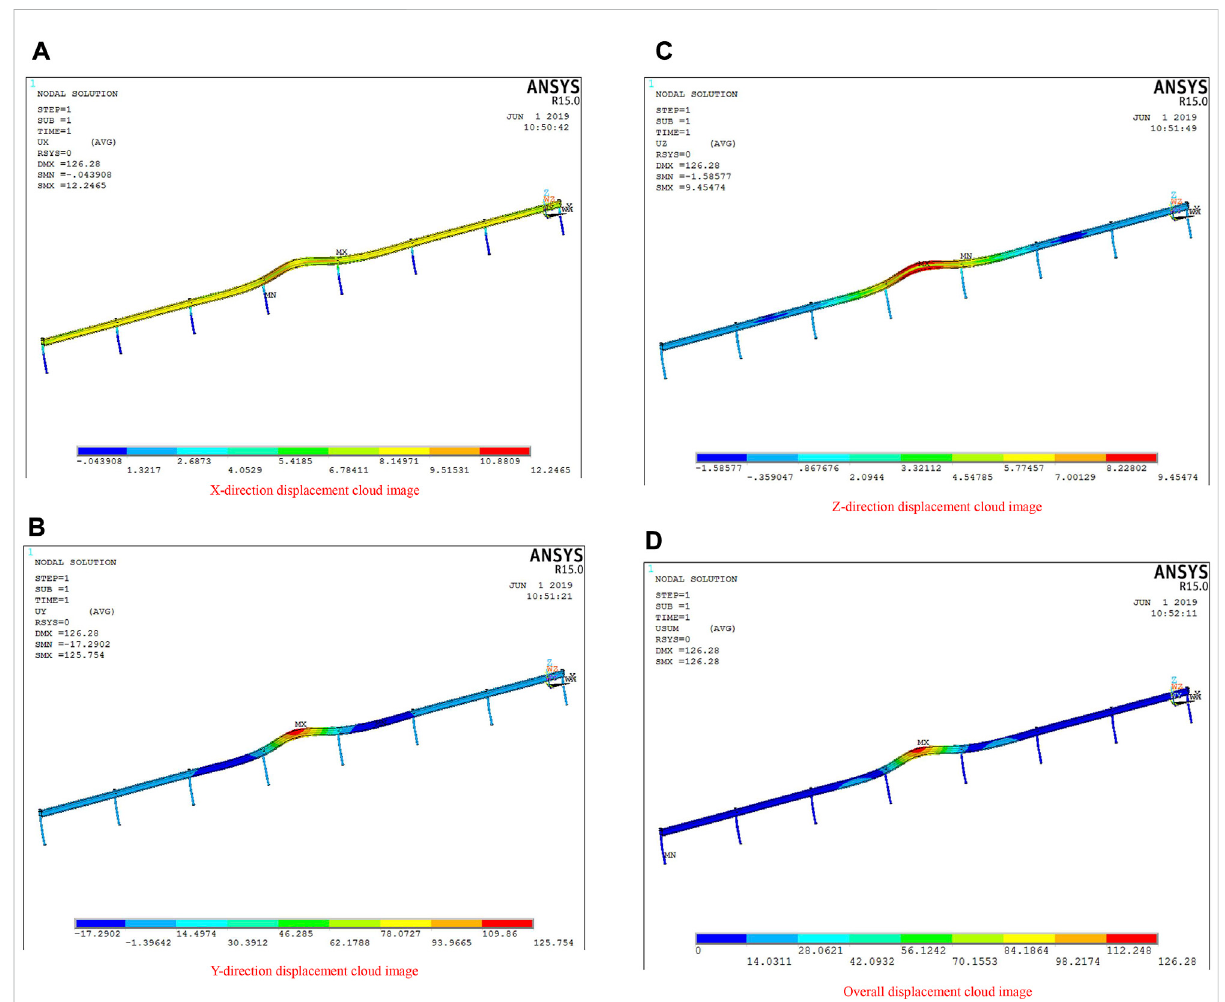
FIGURE 9 Displacementclouddiagramofathree-wavebeamsteelguardrail(impactedbythe1.5-tminibusatthespeedof100 km/hfromanangleof20 ° , thesoil-embeddedguardrailpost). (A) :CloudimageofdisplacementinXdirectionofthree-wavebeamsteelguardrail. (B) :Y-directiondisplacement cloud image of three-wave beam steel guardrail. (C) : Z-direction displacement cloud map of three-wave beam steel guardrail. (D) : Overall displacement cloud image of three-wave beam steel